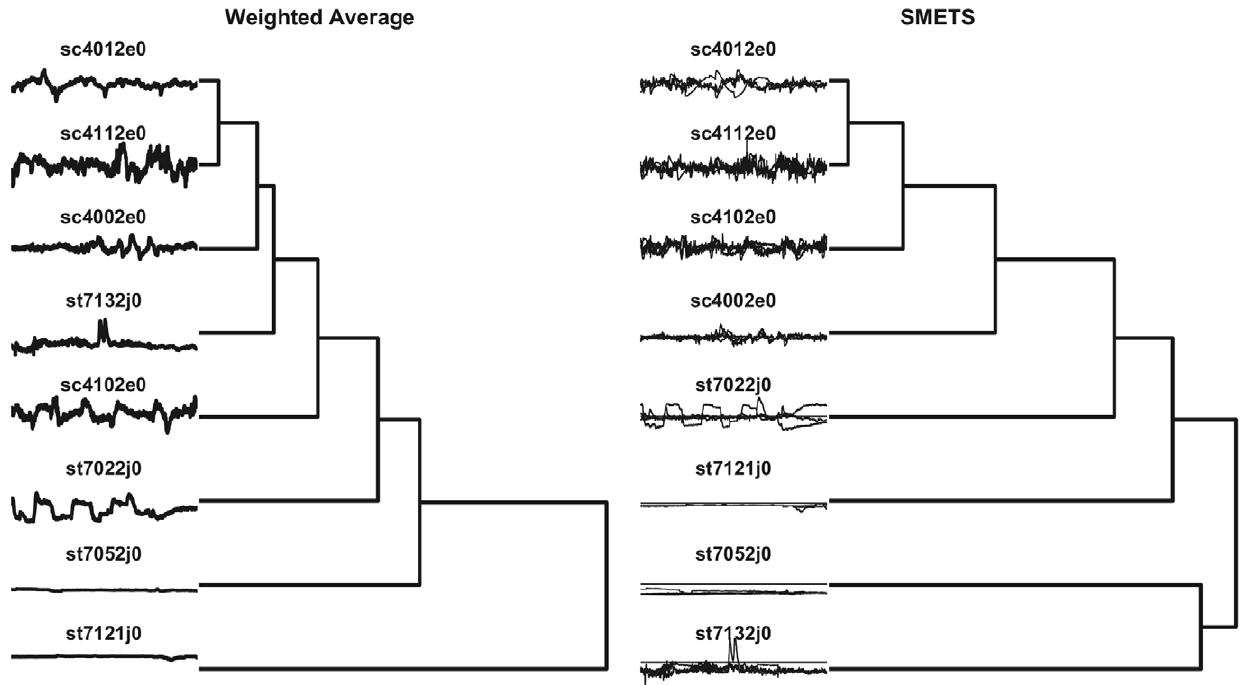
Figure 10. Hierarchical clustering of modified electrophysiological sleep data. Distances were measured using the weighted average method versus SMETS. The dendrogram reveals the relative distances between each entity. The time series considered by each method are represented to the left. All time series have only 5 dimensions, by removing the two extra dimensions from series sc4012e0, sc4112e0, sc4102e0 and sc4002e0 (see Results section for details).